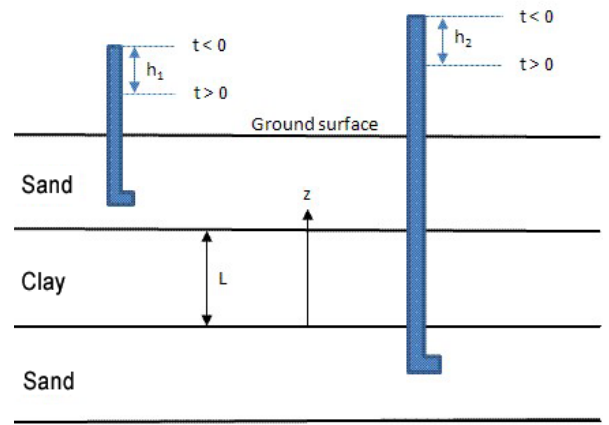
Figure 1. Sketches of soil consolidation due to water table depres-